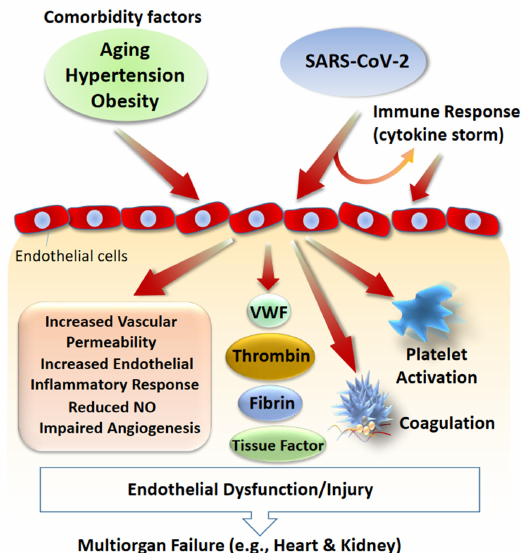
Figure 1. Role of comorbidity factors and SARS-CoV-2 in vascular dysfunction and vascular injury. Endothelial dysfunction is associated with aging and conditions such as hypertension and